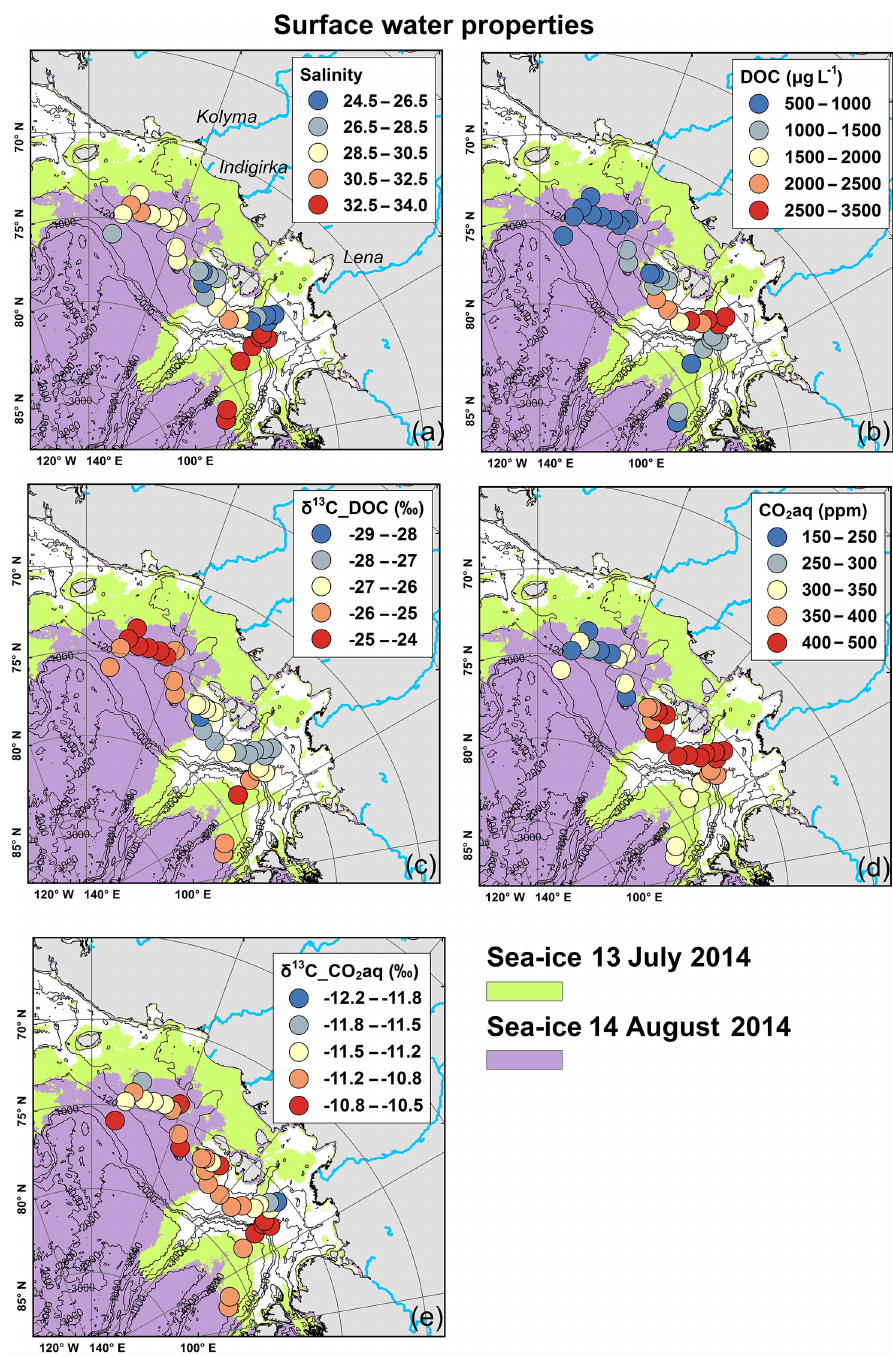
Figure 2. Surface water properties. (a) Salinity. (b) DOC. (c) δ 13 C-DOC. (d) CO 2 aq. (e) δ 13 C-CO 2 aq. Shaded areas show the sea ice extent at the beginning (13 July 2014) and at the end of the sampling campaign (14 August 2014) (Humborg et al., 2017; Salvadó et al., 2016).